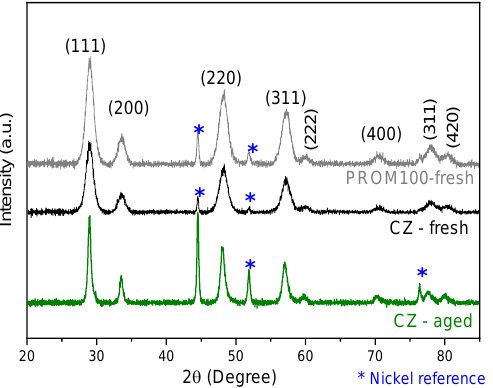
Figure 4. XRD patterns of the CZ- and PROM100-fresh samples. Refractive peaks indicated with asterisk correspond to Ni which was added to samples for calibration purposes.